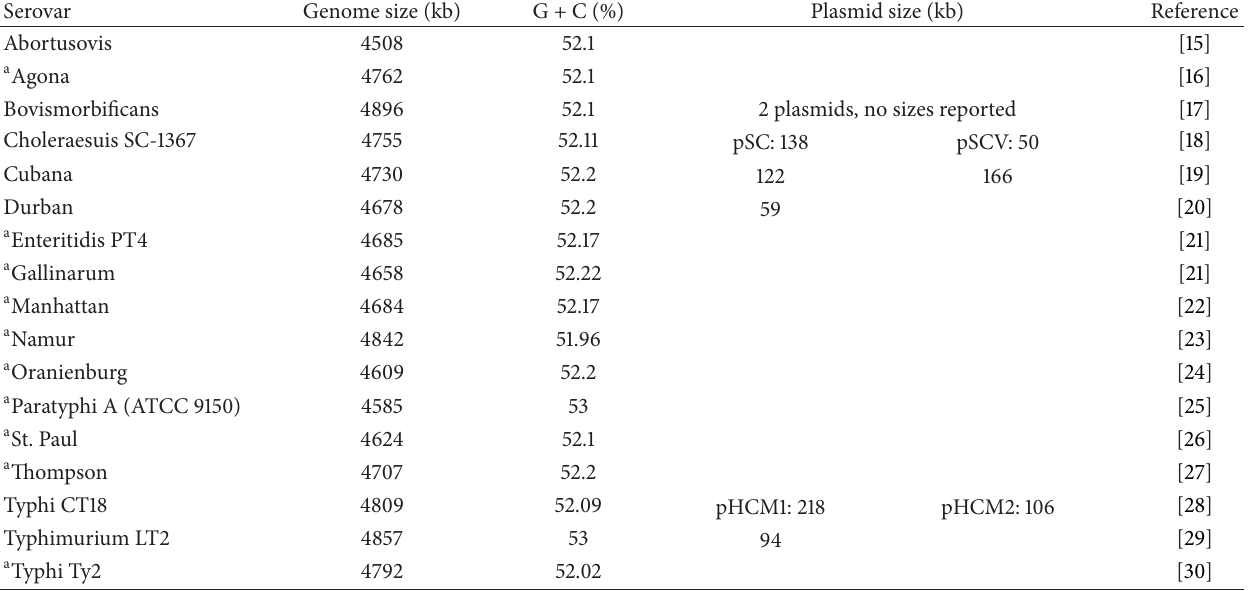
Table 1: Examples of some genomic characteristics of Salmonella serovars.